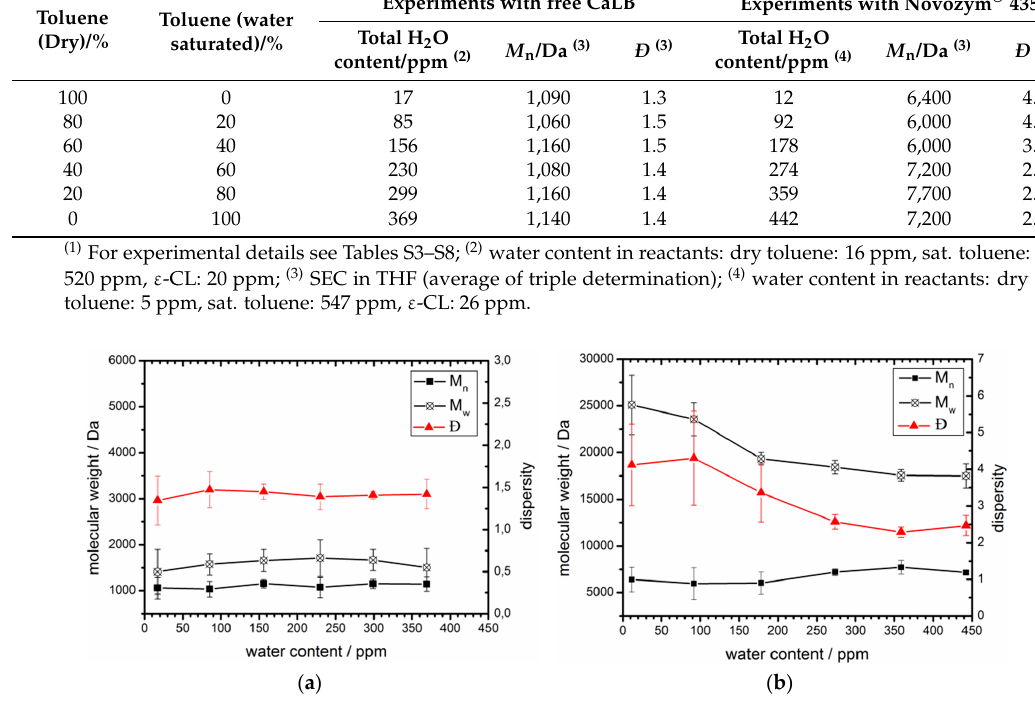
Figure 3. Enzymatic polymerization of ε -CL with ( a ) free CaLB and ( b ) Novozym ® 435 in toluene with varying water content from 0 to 400 ppm. Illustration of the progression of M n , M w and Ð with increasing water content.